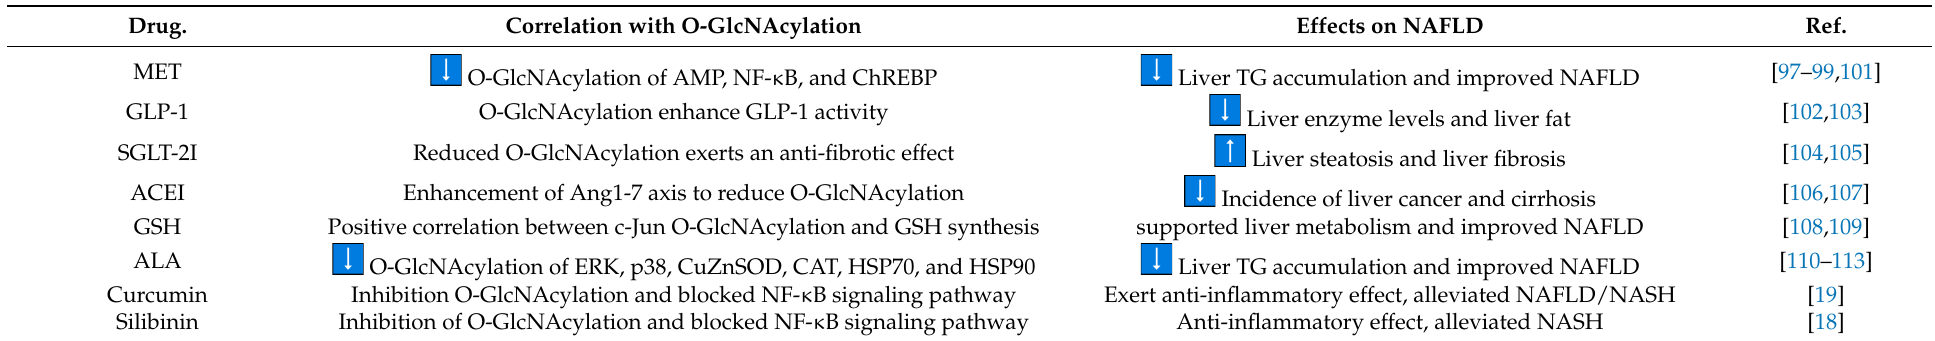
Table 2. Drug interactions with O-GlcNAcylation and